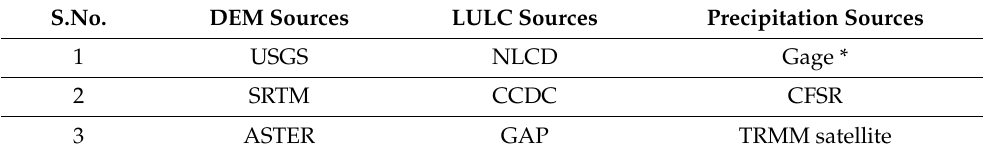
Table 2. List of input data collected for developing the SWAT model